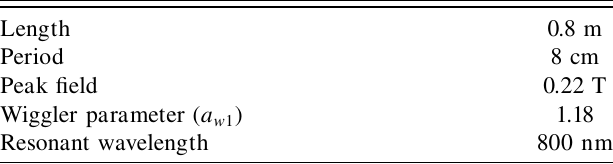
Modulator wiggler parameters.